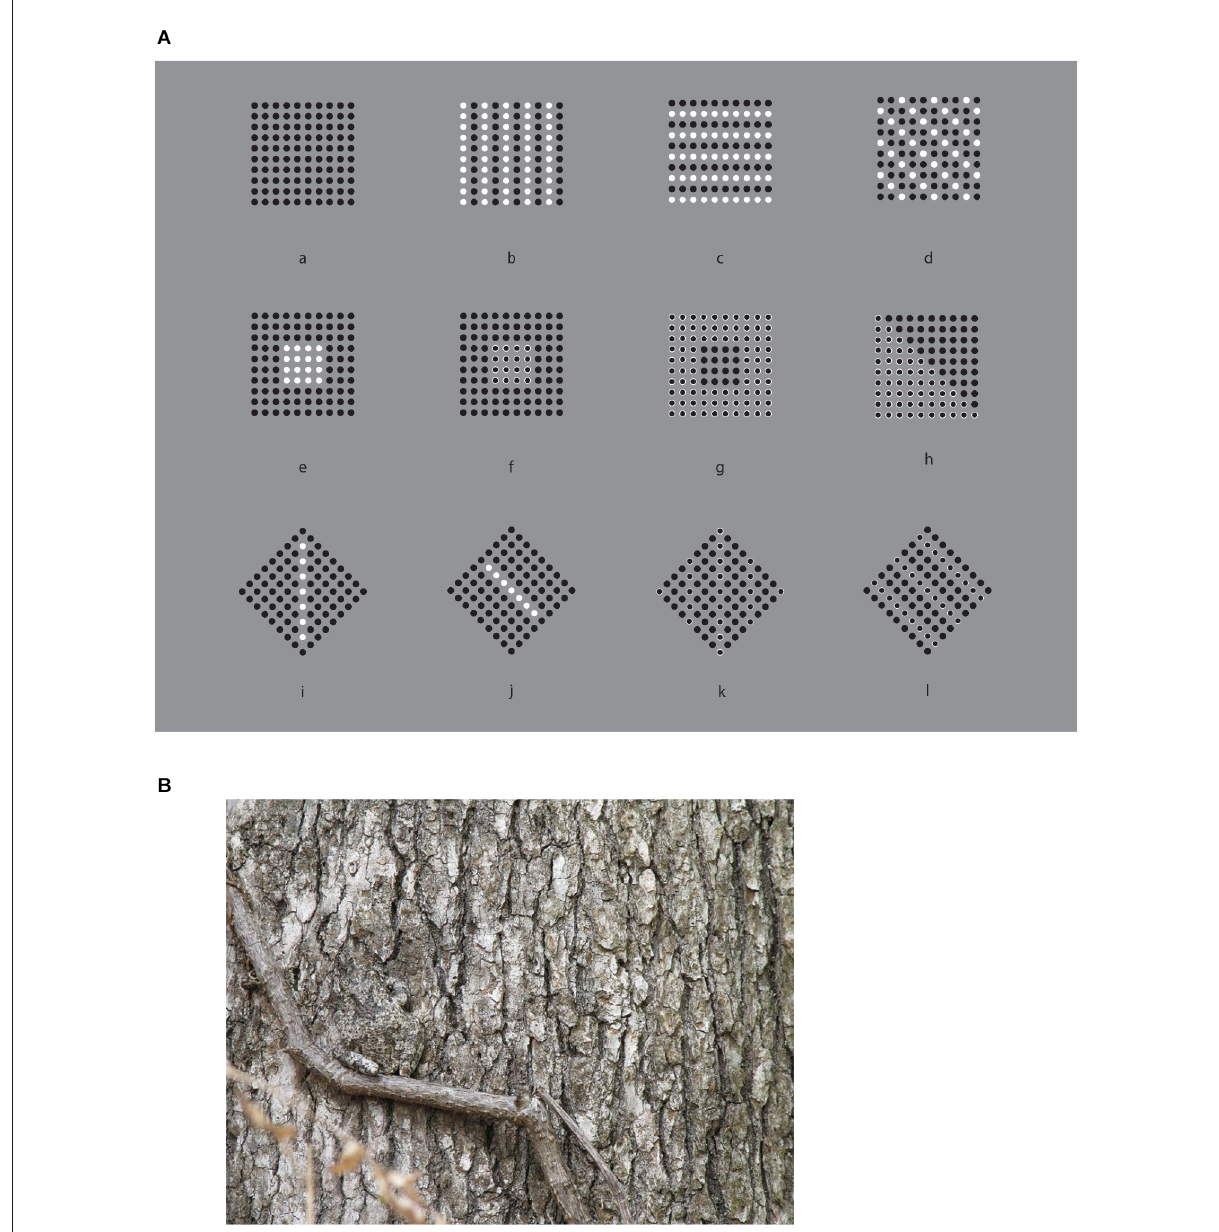
FIGURE1 (A) The proximity and similarity principles: all else being equal, the closest and most similar elements are grouped together creating columns, rows, obliques, inset squares, and right triangles (a-l). (B) Find the